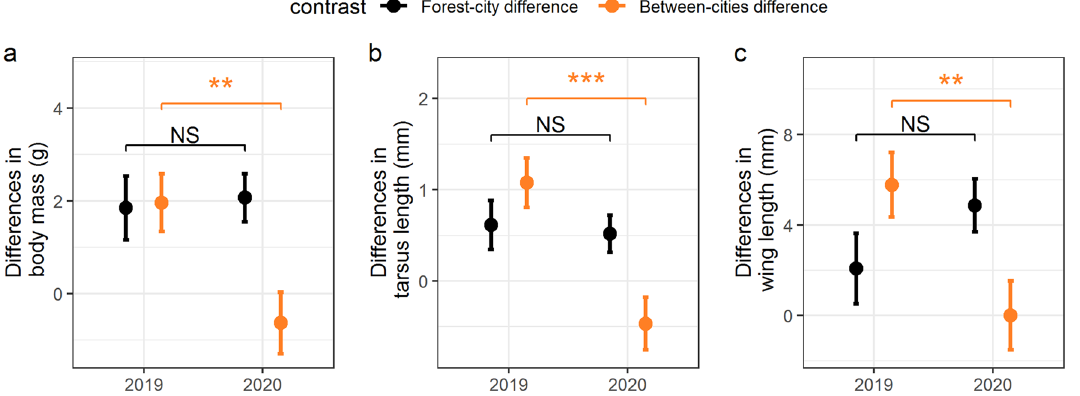
Figure 2. The impacts of the lockdown on nestlings’ body mass, tarsus length, and wing length in urban and forest populations of great tits. Black colour indicates comparisons between a forest (Szentgál, not affected by the lockdown) and a nearby urban site (Veszprém, where the lockdown decreased human activity around the nests), whereas orange colour shows comparisons between Veszprém and the capital city, Budapest (where the lockdown increased human activity at the study sites). Panels show the differences between these populations for 2020 (when breeding occurred during the lockdown) and for a reference year (2019). Differences are expressed as forest minus urban (forest-city comparisons) and Budapest minus Veszprém (between-cities comparisons), thus positive differences mean higher values in the forest or in Budapest, respectively, than in Veszprém. A smaller difference in 2020 than in 2019 indicates better relative performance of birds breeding in Veszprém during the lockdown. Number of broods (2019 and 2020), Szentgál: 11 and 22; Veszprém: 21 and 30; Budapest: 15 and 10. Results are from linear models’ estimates (mean ± SE). Population differences were statistically compared between 2019 and 2020 (***: 0 > P > 0.001; **: 0.001 > P > 0.01; *: 0.01 > P > 0.05), see Table 1 for details.